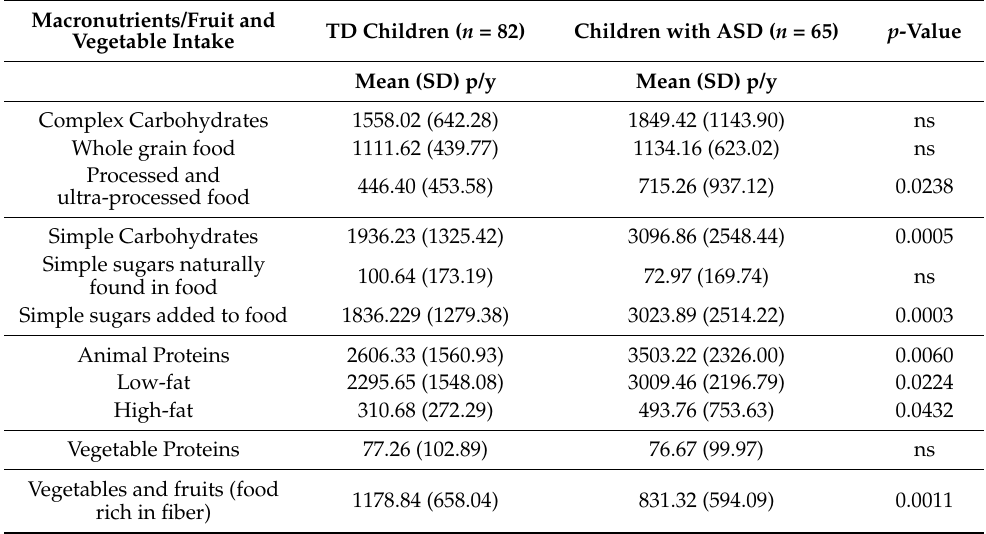
Table 4. Comparison of annual intake of macronutrients/fruit and vegetable intake between children with ASD and typically developing children. Mean values are expressed in